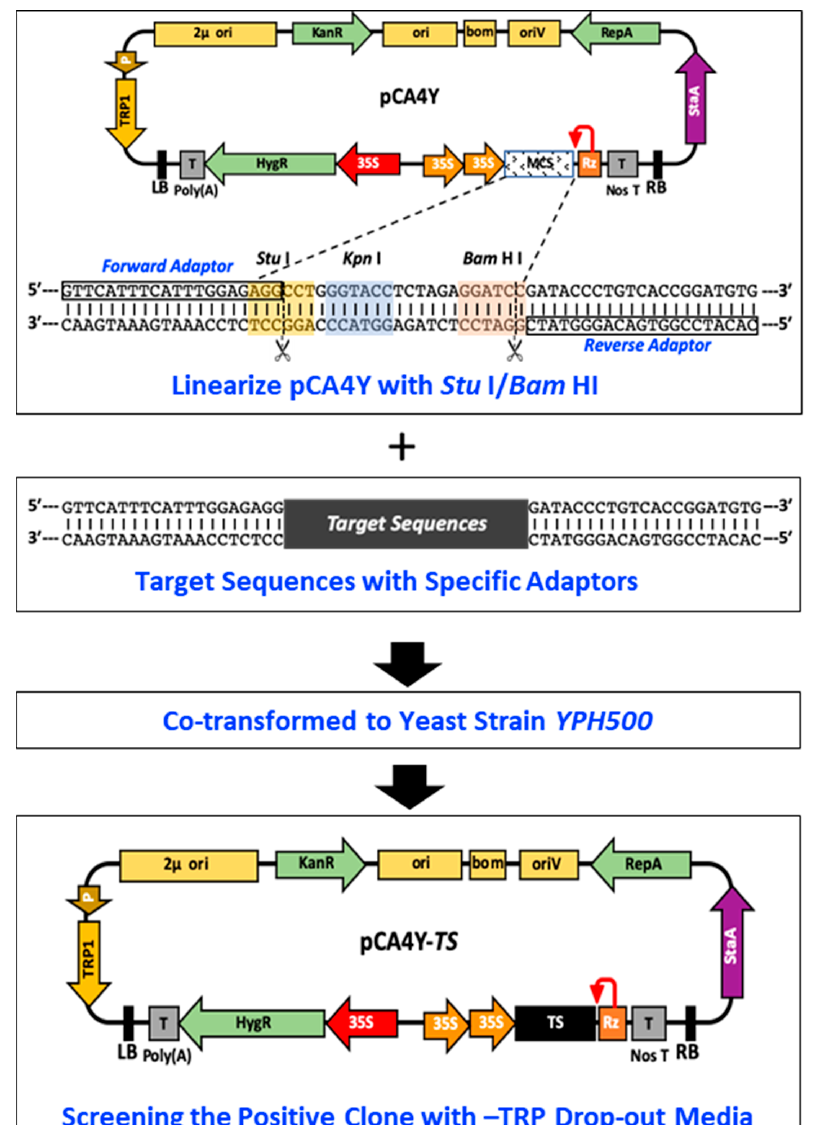
Figure 2. Schematic illustration of the construction procedures based on yeast homologues recombination. First, we should linearize the pCA4Y by Stu I and Bam HI double-digestion (vector). Then, to obtain the target fragment by amplification the fragments with specific adaptor shown above (fragments). If the construction involved multiple fragments ligation, each pair of adjacent fragments should have a homologues sequence with at least 20 bp length. Second, the prepared fragments and vector were co-transformed to the yeast strain YPH500 , and the positive clones were screened by the TRP1 drop-out medium with kanamycin and PCR with specific